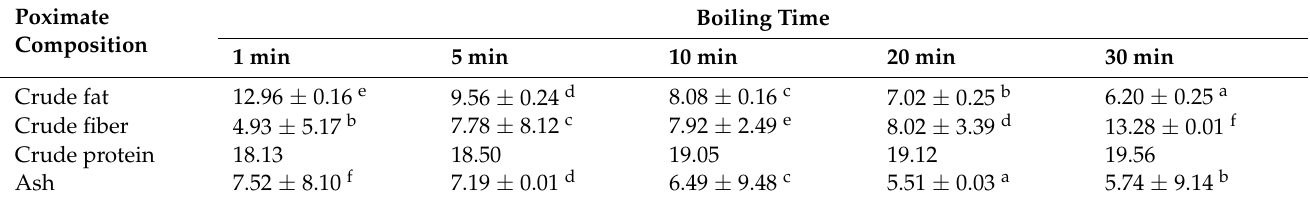
Table 2. Effects of boiling time on proximate composition of red